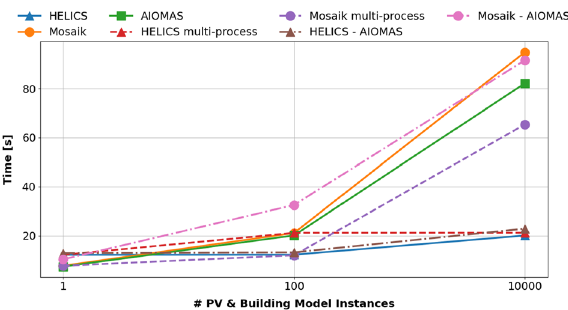
Fig. 11 Zoom on the first 10,000 instances for the Total execution time